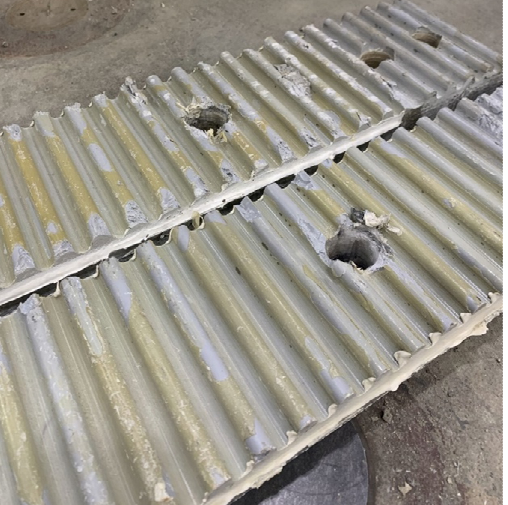
Figure 1. Deformed FRP Girder Top Flanges Used in Shear-Friction Connection.